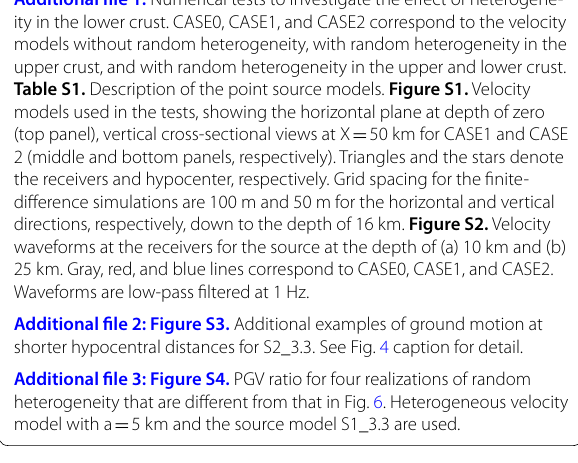
Table S1. Description of the point source models. Figure S1. Velocity models used in the tests, showing the horizontal plane at depth of zero (top panel), vertical cross-sectional views at X 50 km for CASE1 and CASE = 2 (middle and bottom panels, respectively). Triangles and the stars denote the receivers and hypocenter, respectively. Grid spacing for the finite- difference simulations are 100 m and 50 m for the horizontal and vertical directions, respectively, down to the depth of 16 km. Figure S2. Velocity waveforms at the receivers for the source at the depth of (a) 10 km and (b) 25 km. Gray, red, and blue lines correspond to CASE0, CASE1, and CASE2. Waveforms are low-pass filtered at 1 Hz. Additional file 2: Figure S3. Additional examples of ground motion at shorter hypocentral distances for S2_3.3. See Fig. 4 caption for detail. Additional file 3: Figure S4. PGV ratio for four realizations of random heterogeneity that are different from that in Fig. 6. Heterogeneous velocity model with a 5 km and the source model S1_3.3 are =